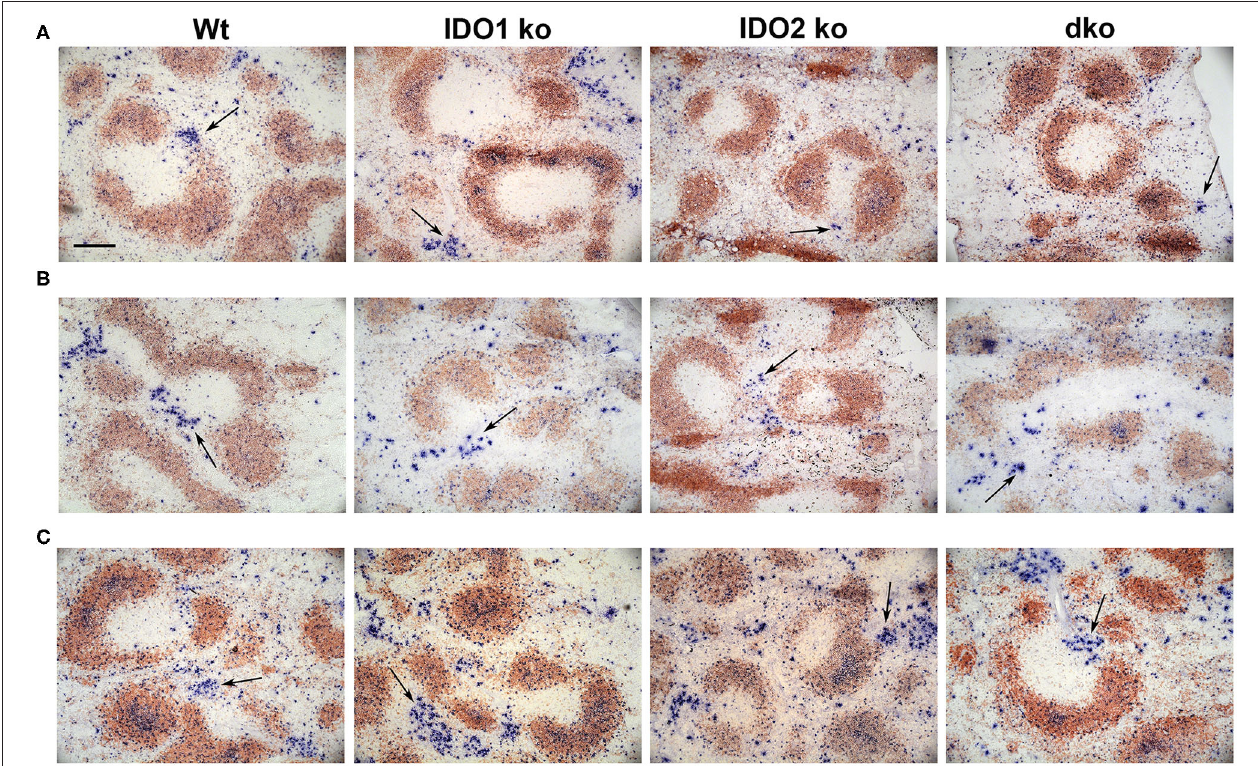
FIGURE 9 | Localization of antibody secreting cells in immunized mice. Wt, IDO1 ko, IDO2 ko, and dko C57BL/6 mice were immunized with (A) NP-Ficoll, (B) NP-LPS, or (C) NP-KLH. Spleens were harvested on day 7 (NP-Ficoll and NP-LPS) or day 10 following primary immunization (NP-KLH). Sections were stained with B220 (red) and Ig λ (blue). Representative images are shown from n = 3 mice per genotype from each immunogen. Antibody secreting cells (ASCs) are marked with arrows. Scale bar = 200 µ